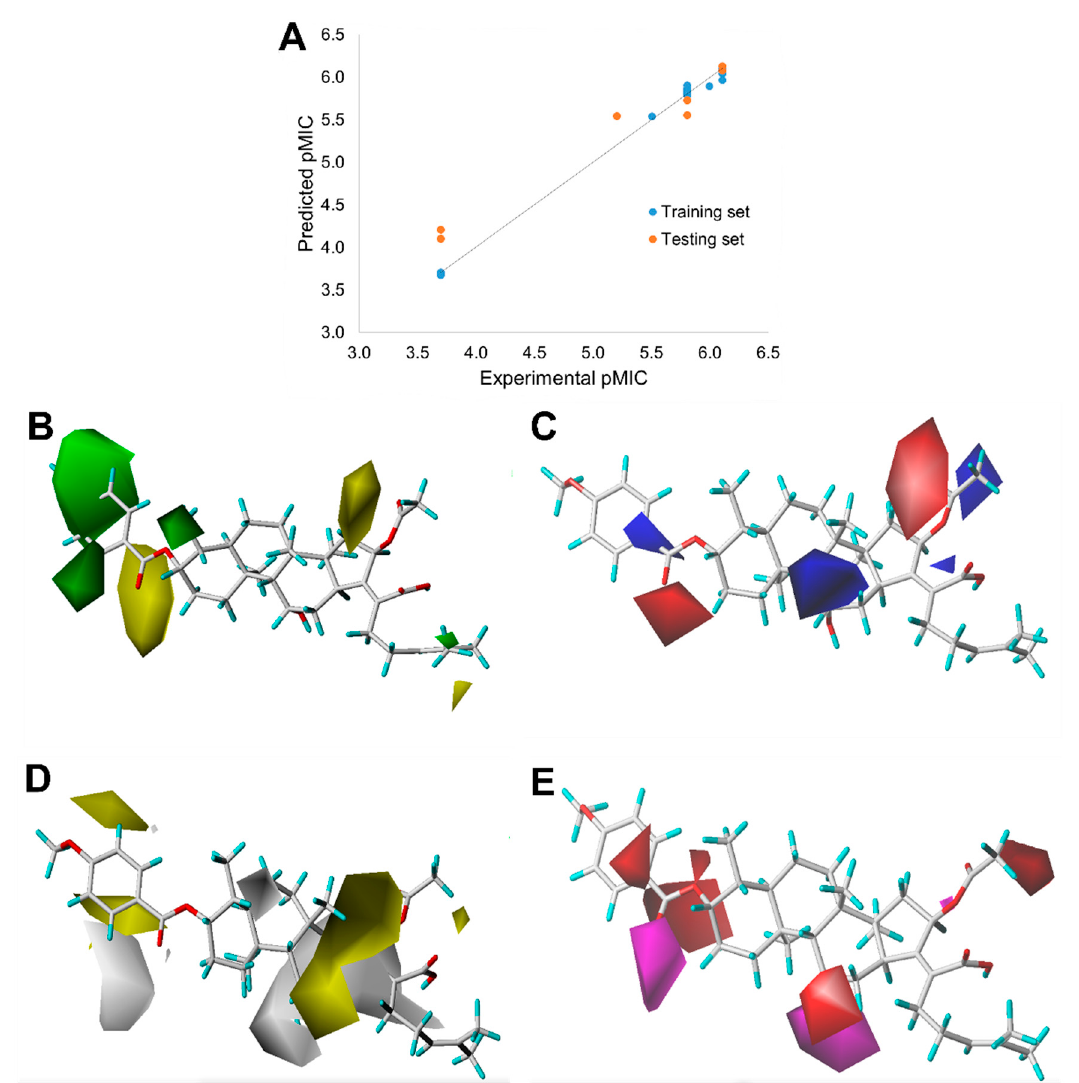
Figure 6. ( A ) Correlation between the experimental bacterial inhibitory activity and predicted activity of the phase QSAR model (pMIC = − lg MIC), showing that R 2 = 0.963: ( B ) steric fields with green favorable, and yellow unfavorable; ( C ) phase electrostatic fields with blue favorable, and red unfavorable; ( D ) hydrophobic fields with yellow favorable and white unfavorable; and ( E ) H-bond acceptor fields with magenta favorable and red unfavorable.